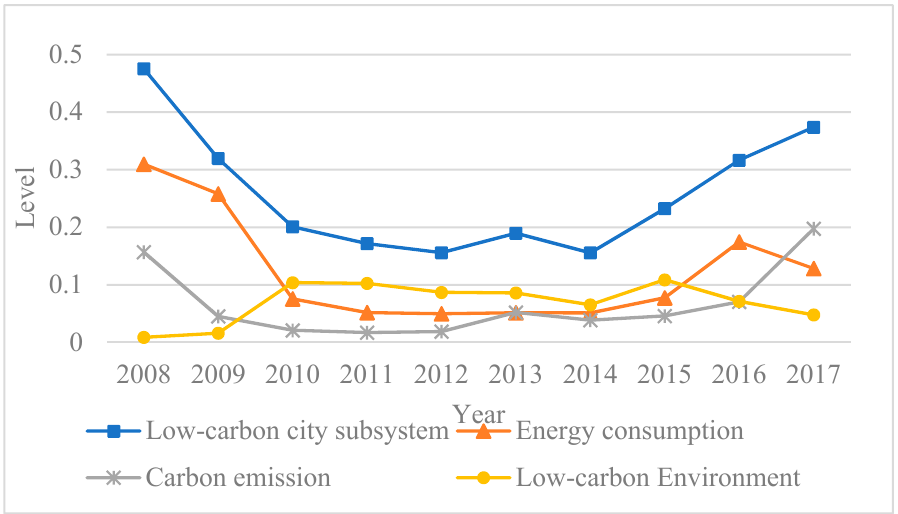
Figure 5. Comprehensive LLC subsystem levels.